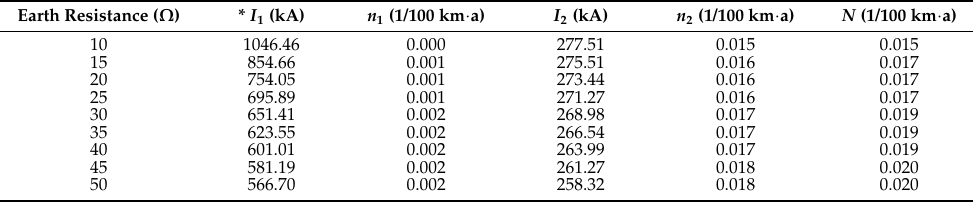
Table 6. Lightning trip rate under different earth resistance of Type2 insulator. Earth Resistance ( Ω